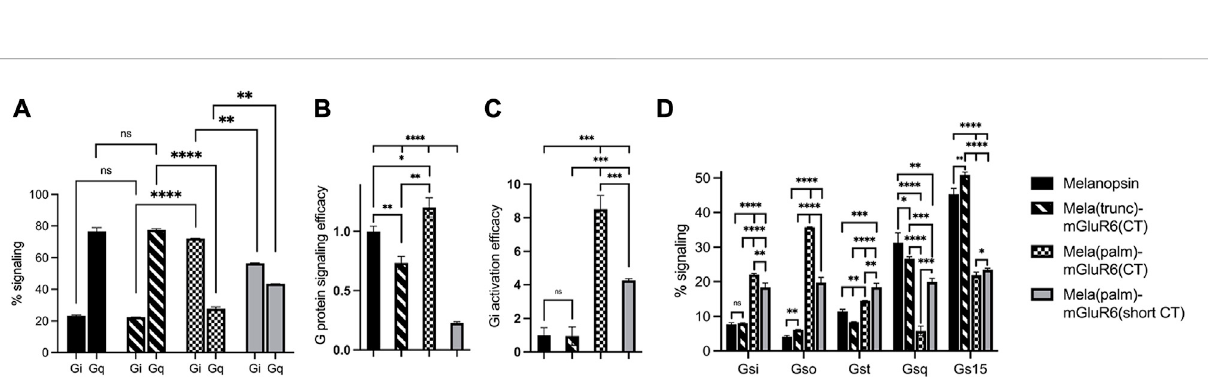
FIGURE 4 TheroleoftheproximalC-terminusinMela-mGluR6chimerasinshiftingtropismfromGqtoGideterminedbytheGsXsecondmessengerassay. (A) The proximal C-terminus is responsiblefor G protein selectivity inthe Mela-mGluR6 chimera and theanalogueregion steers G-protein selectivity also in mGluR6.ThepercentualproportionofeachG-proteinsubfamilyintotalGqandGisignaling(100%)wascalculatedbydividingthemax.cAMPresponseof each GsX-protein by the total sum of all max. GsX values. (B) The total G-protein signaling ef fi cacy was determined by calculating [Gi(total)+Gq(total)]/2. This was performed to quantify the functionality of the chimeric constructs. (C) The Gi activation ef fi cacy ratio was calculated by dividing the summed mx. Gi values by the summed max. Gq values indicating the shift from Gq to Gi signaling. WT melanopsin was normalized to 1, all other variants were normalized to WT melanopsin. (D) The percentage of each G-protein in total signaling (100%) was calculated by dividing the max. cAMP response of each GsX-proteinby the total sum of all GsX-proteins resulting in a fi ngerprint of theGi and Gq signaling pro fi les of these variants. N = 3; light stimulus: array of 3 × 8 LEDs, 470 nm, 5 × 10 16 photons/cm 2